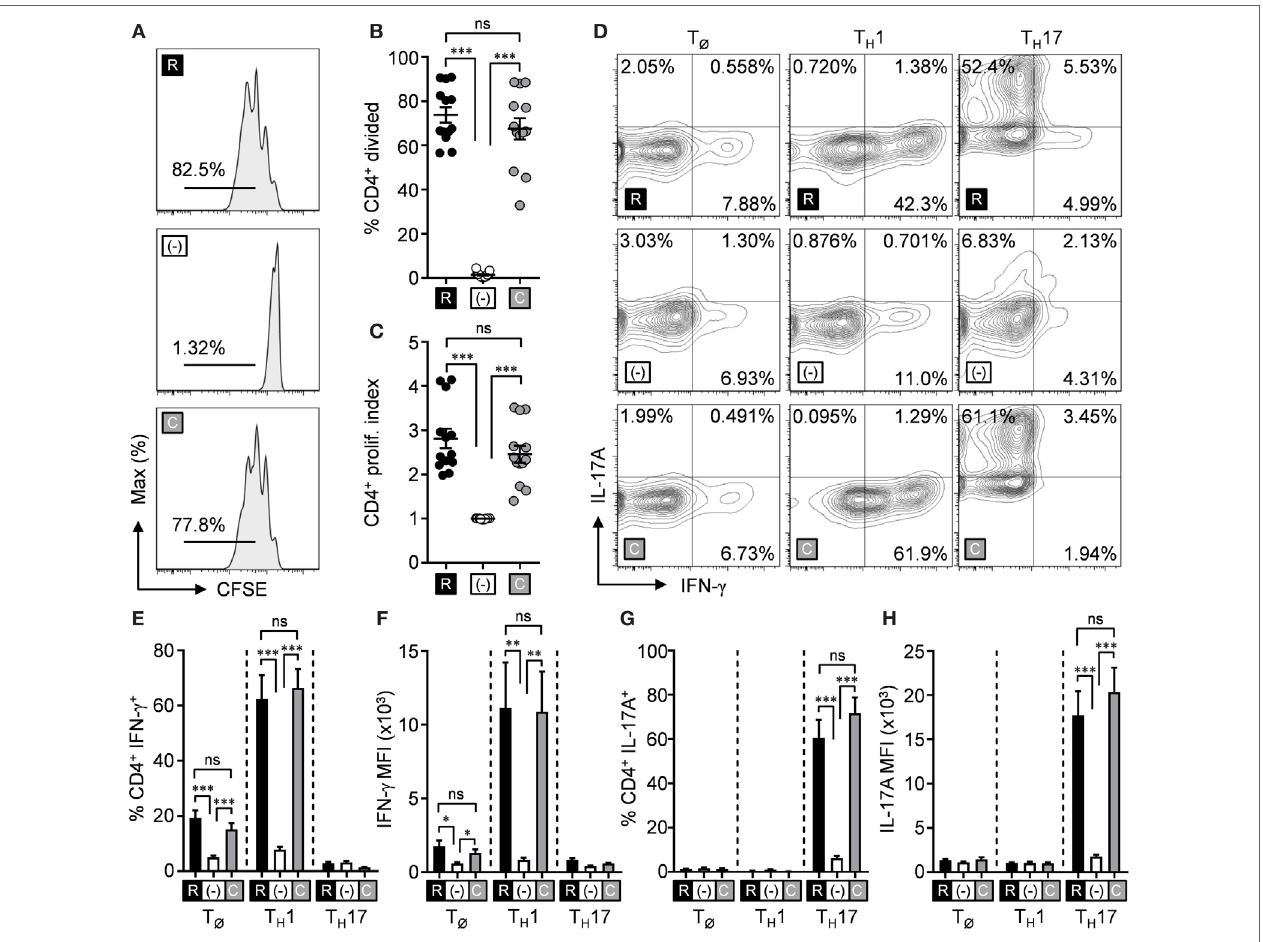
FigUre 1 | l - c itrulline rescues T cell functions in the absence of l -arginine. (a–c) Lymphocytes from wild-type mice (C57Bl/6 background) were isolated and stained with carboxyfluorescein succinimidyl ester (CFSE). Cells were stimulated with α -CD3 and α -CD28 in R-free RPMI supplemented with 1 mM l -arginine (black), 1 mM l -citrulline (gray), or neither amino acid added (white) for 72 h. CFSE dilution of CD3 + CD4 + T cells was analyzed by flow cytometry. Data are displayed as representative histograms (a) , mean percent of divided cells (B) , and proliferation index (c) as defined in the methods. Data are combined from four experiments. (D–h) Lymphocytes from wild-type mice were polarized under T Ø , T H 1, or T H 17 polarizing conditions for 5 days in the indicated culture conditions (see Materials and Methods). Following restimulation, cells were stained for intracellular cytokines and analyzed by flow cytometry. Cytokine-producing cells are represented in the graphs by mean frequency of single-positive, cytokine-expressing cells (e,g) , and mean fluorescence intensity of the indicated cytokine (F,h) . Data are combined from three experiments. Error bars, SEM. * p < 0.05, ** p < 0.01, *** p < 0.001 by Student’s t